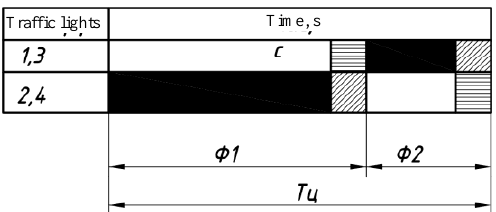
Fig 4. Corrected diagram of 2-phase traffic lights cycle at rush hours according to the law of hourly traffic